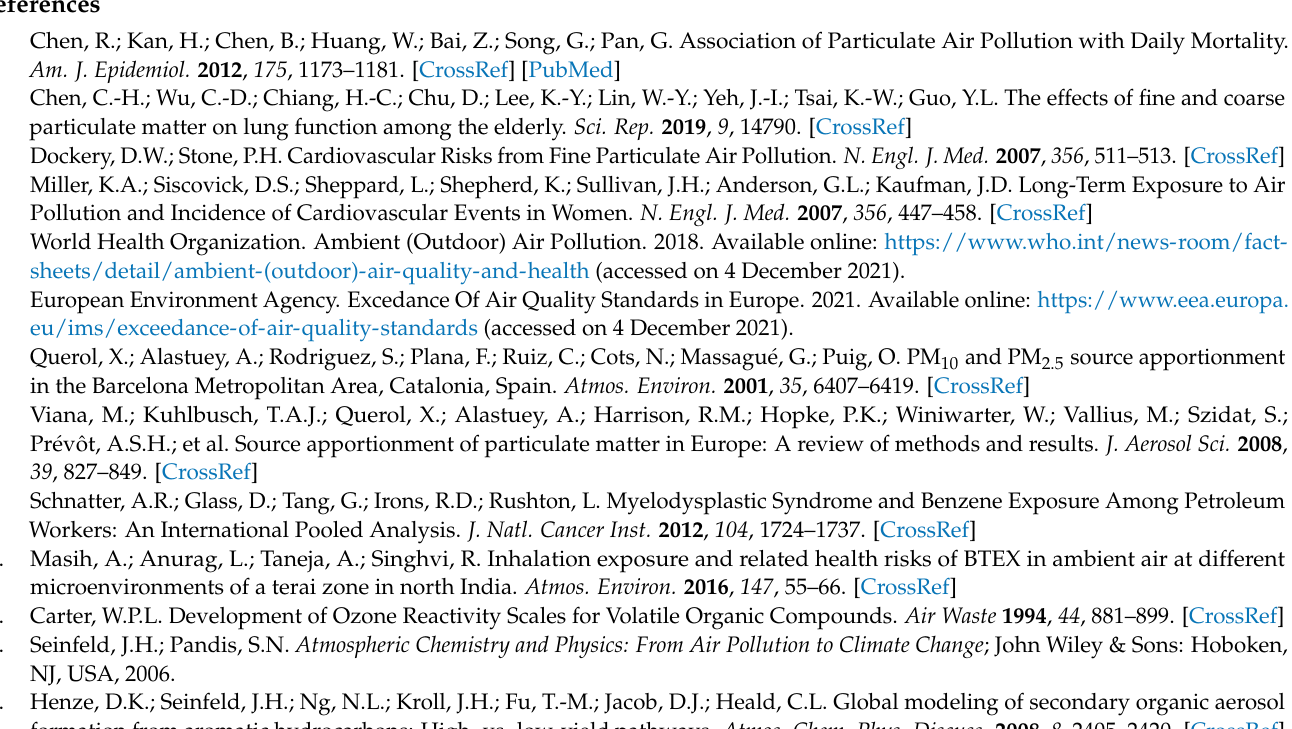
the lockdown periods. Figure S4: Hourly PM 2.5 profile comparing reference and lockdown periods; Figure S5: Hourly PM 10 profile comparing reference and lockdown periods; Figure S6: Hourly PM 10 concentration profile by environment type for reference and lockdown periods; Figure S7: Hourly PM 2.5 concentration profile by environment type for reference and lockdown periods; Figure S8. PM and meteorological variables time series to illustrate anticorrelation in ( a ) ALM and ( b ) TARO and correlation in ( c ) CEME stations during